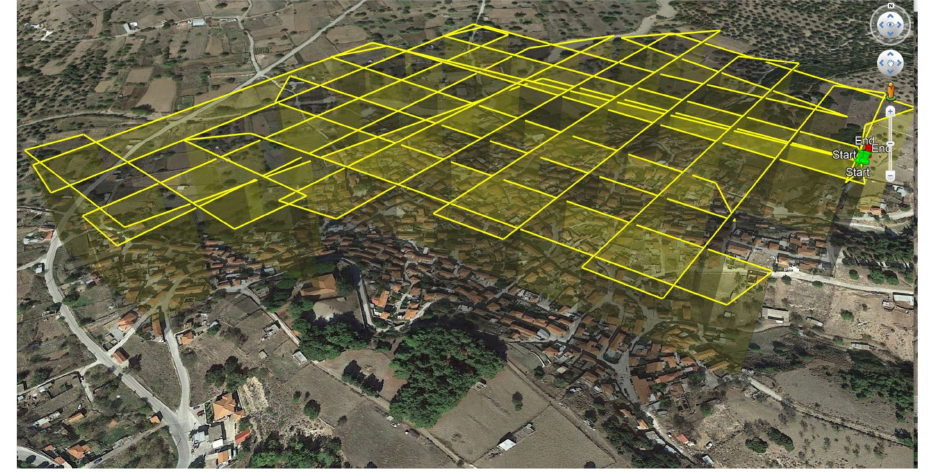
Figure 3. The flight path designed for covering the area of interest as it appears on Google Earth satellite base map.